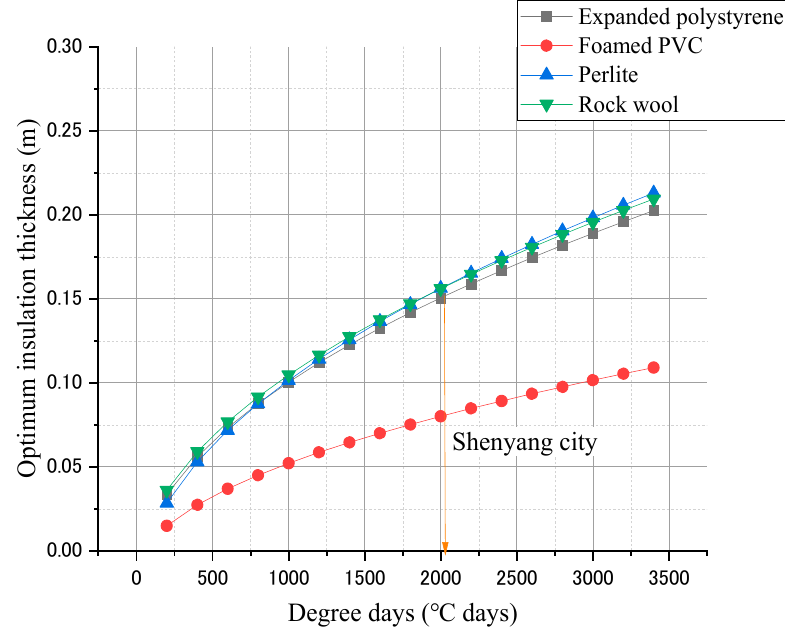
Figure 8. The effect of R wt on the payback period for different insulating materials at the optimum thickness.